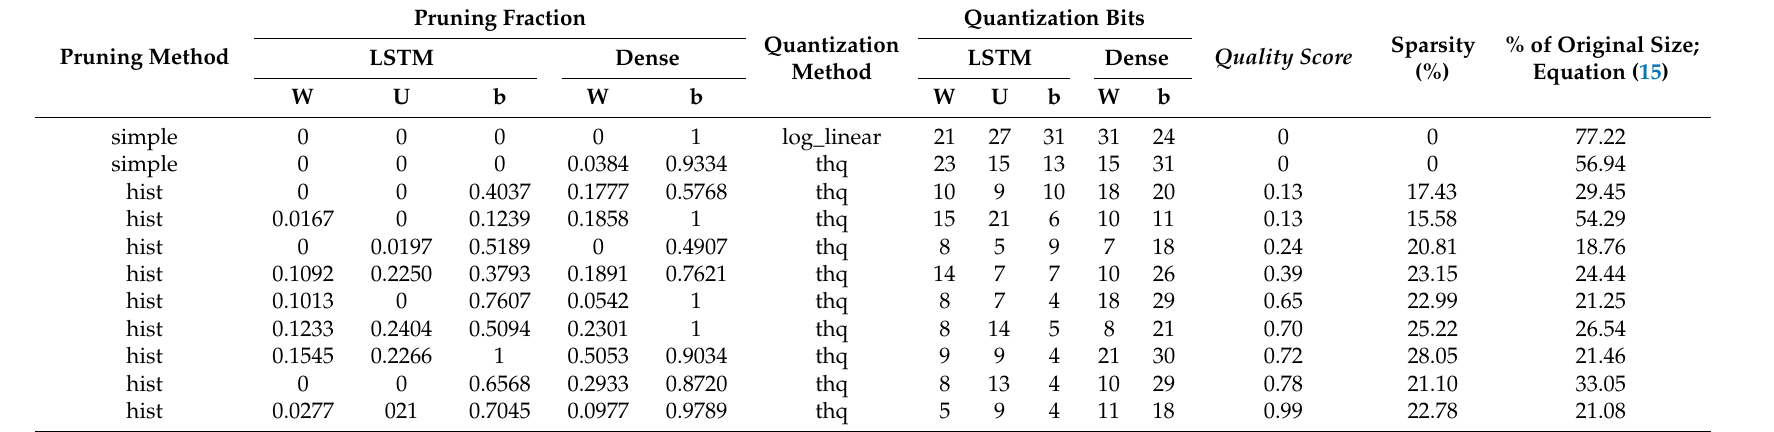
Table A5. [PM2.5] Results for individualized pruning and